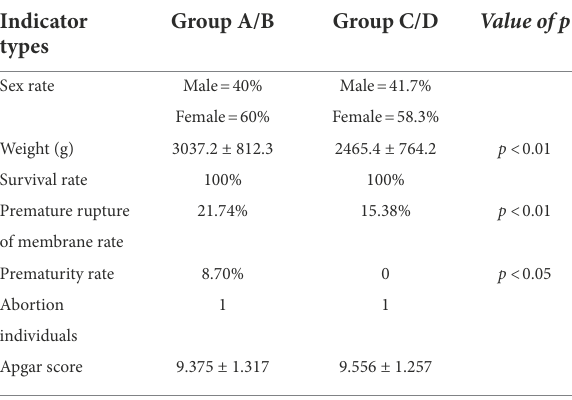
TABLE 1 Analyses of the pregnancy outcomes from normal pregnant women and pregnant women with cervical